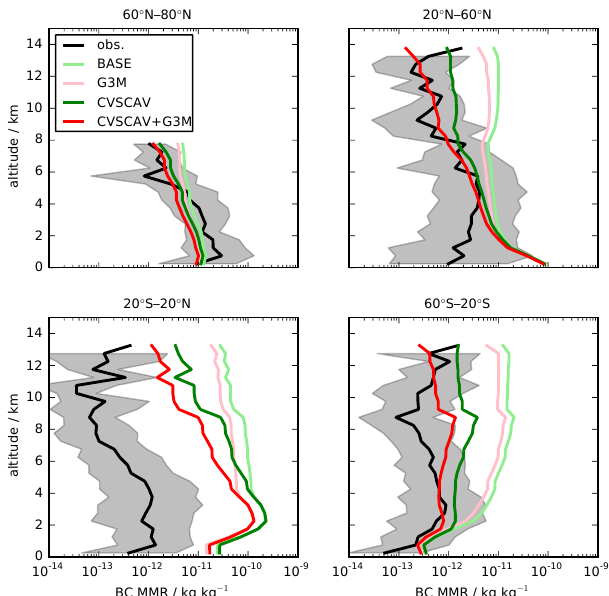
Fig. 6. Vertical profile curves of BC mass mixing ratio for HIPPO-1 and horizontally-matched locations in the January 2009 monthly- mean output from the HadGEM3–UKCA simulations. The shaded region shows the (geometric) standard deviation of the observed MMR values over the profiles in each latitude band, plus the ± 30% measurement